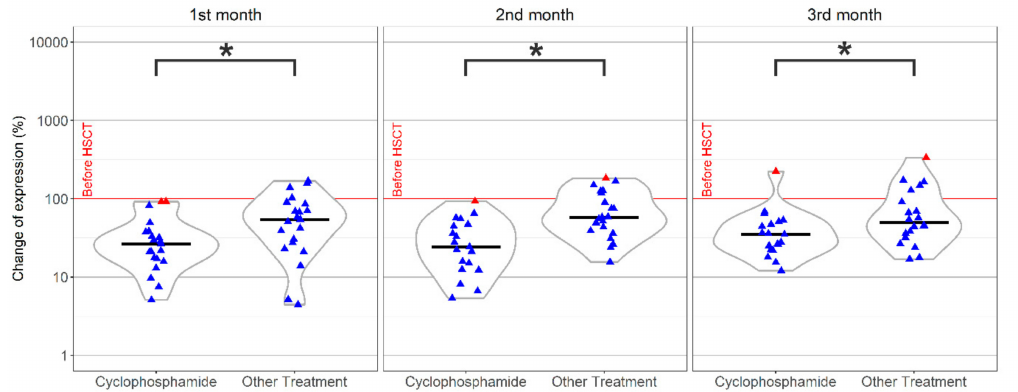
Figure 3. The percentage change of KIR2DL1 expression. The KIR2DL1 was downregulated in almost all patients and displayed di ff erent behaviors, depending on the graft-versus-host disease (GvHD) prevention treatment. The group receiving cyclophosphamide (Cy) exhibited a much more reduced expression than the group not receiving Cy. * statistically significant results ( p < 0.05). Outliers, . Median,